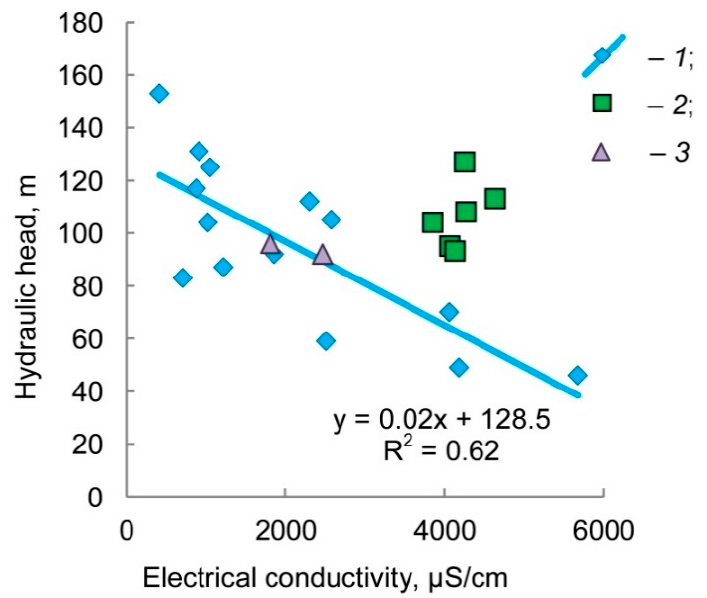
Figure 5. Areas with anomalies in the uranium isotopic composition and hydraulic head: 1 —anomalies of the uranium-234 content ( 234 U/ 238 U > 7.8); 2 —points where the hydraulic head, calculated taking into account the temperature and water salinity, deviates from the regional trend (Figure 6).